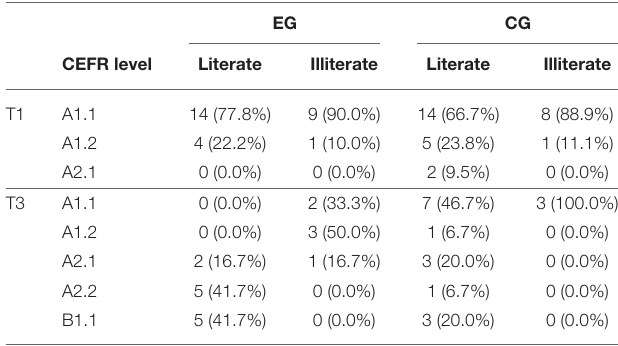
TABLE 3 | Results of participants in the experimental group (EG) and control group (CG) at baseline (T1) and after 1 year